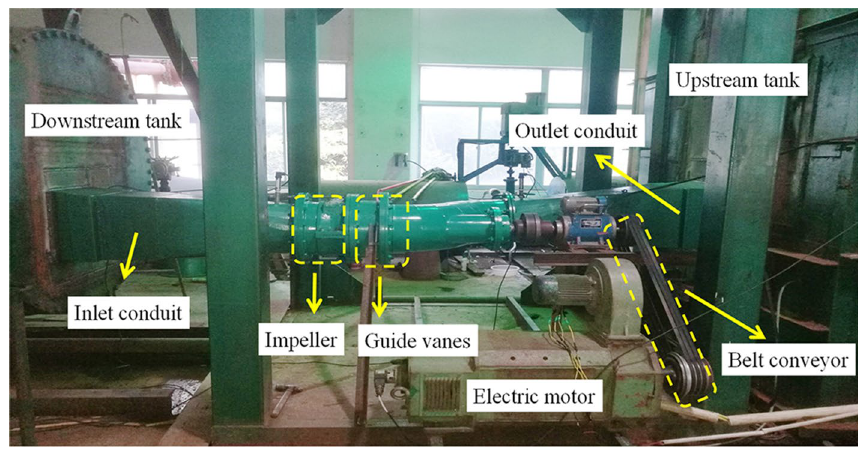
Figure 5. Schematic diagram of model test bench for horizontal axial flow pump with ultra-low head.